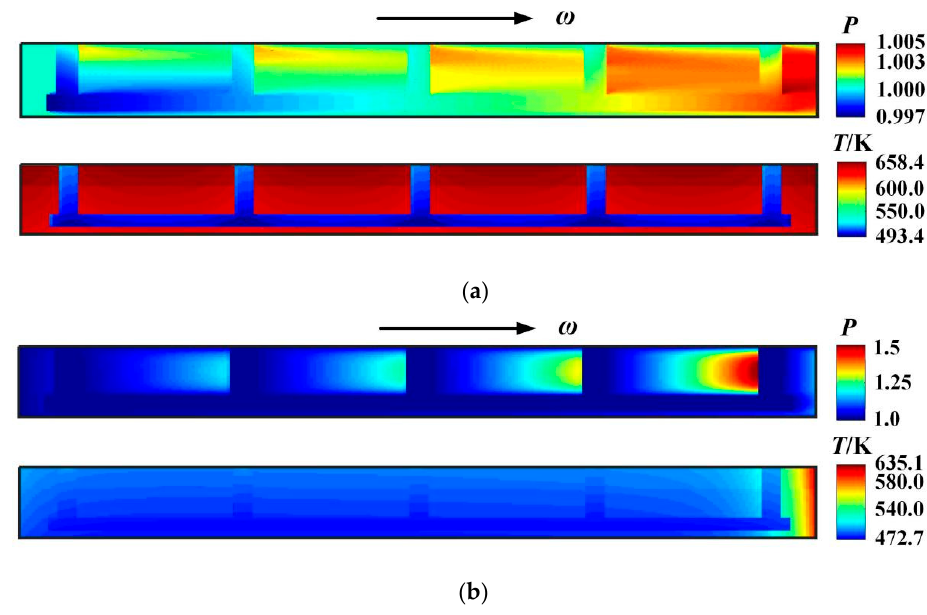
Figure 4. Pressure distribution and temperature distribution of split floating ring seal. ( a ) β = 0 rad; ( b ) β = 20×10 − 6 rad ( p i = 0.1 MPa, ω = 3.0 × 10 4 r/min, T in = 580 K, T out = 380 K, β = 0/2e − 5 rad).